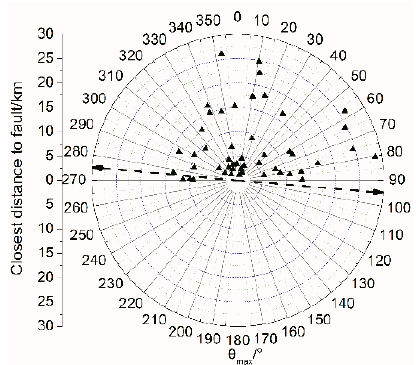
Figure 14. The distribution of θ max for the identified pulse-like near-fault seismic motions during the Chi-Chi event.